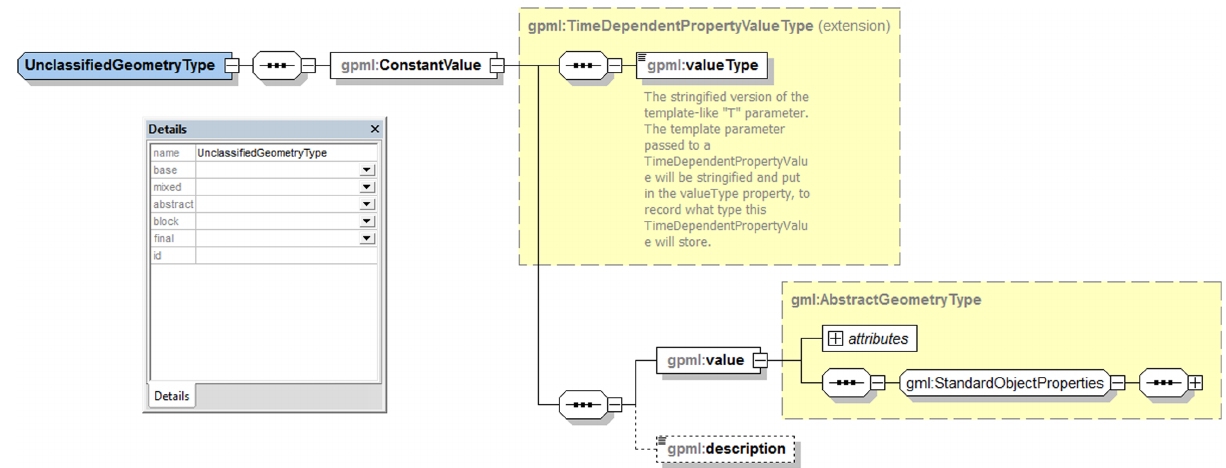
Fig. 21. The unclassifiedGeometry schema diagram in GPML.